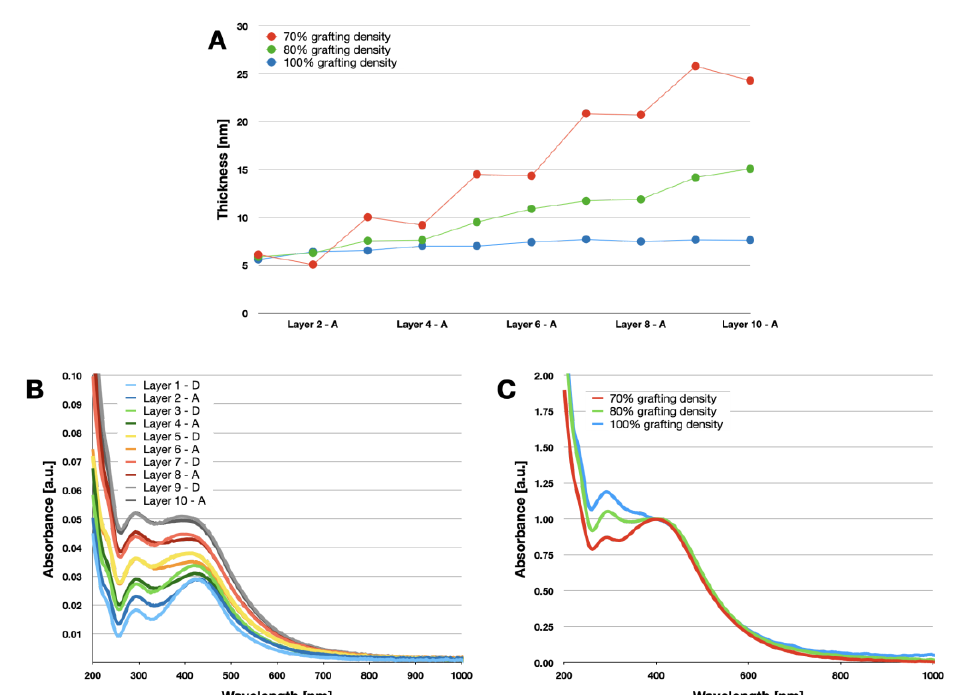
Figure 1. Characterization of D-A polymer brushes obtained via Sonogashira coupling reaction: ( A ) thickness of the material with different grafting density on silica substrate, ( B ) UV-Vis spectra after deposition of each layer for a sample with 80% grafting density on quartz substrate, ( C ) normalized UV-Vis spectra of the (D-A) 5 brushes with various grafting density on quartz substrate.